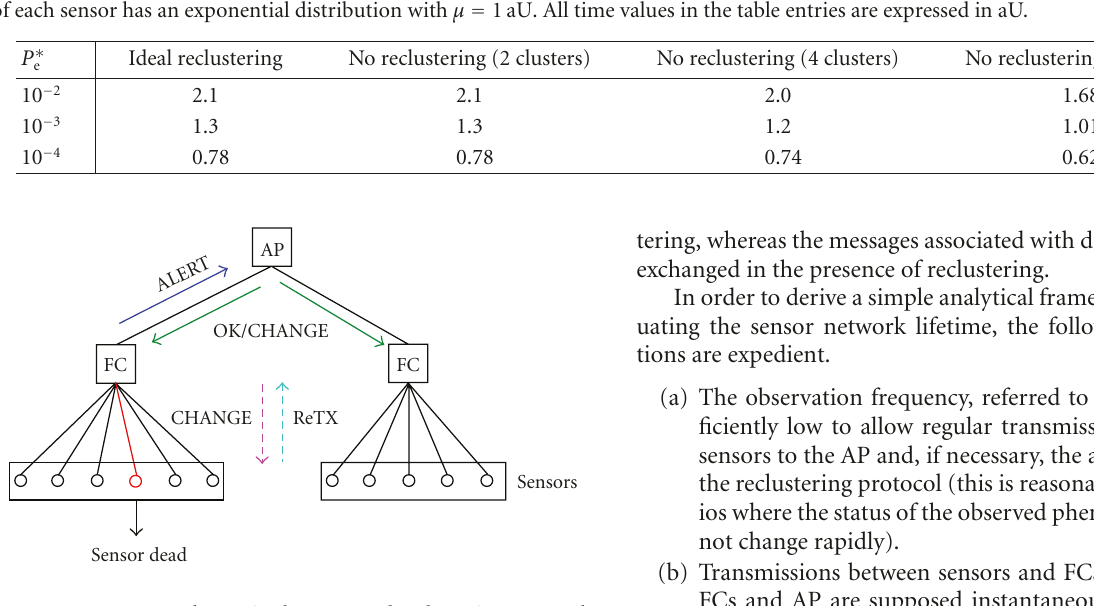
Figure 7: Message exchange in the proposed reclustering protocol. A network scenario with N = 11 sensors and two clusters (with 6 and 5 sensors, resp.) is considered. The control messages evolution follows the death of a